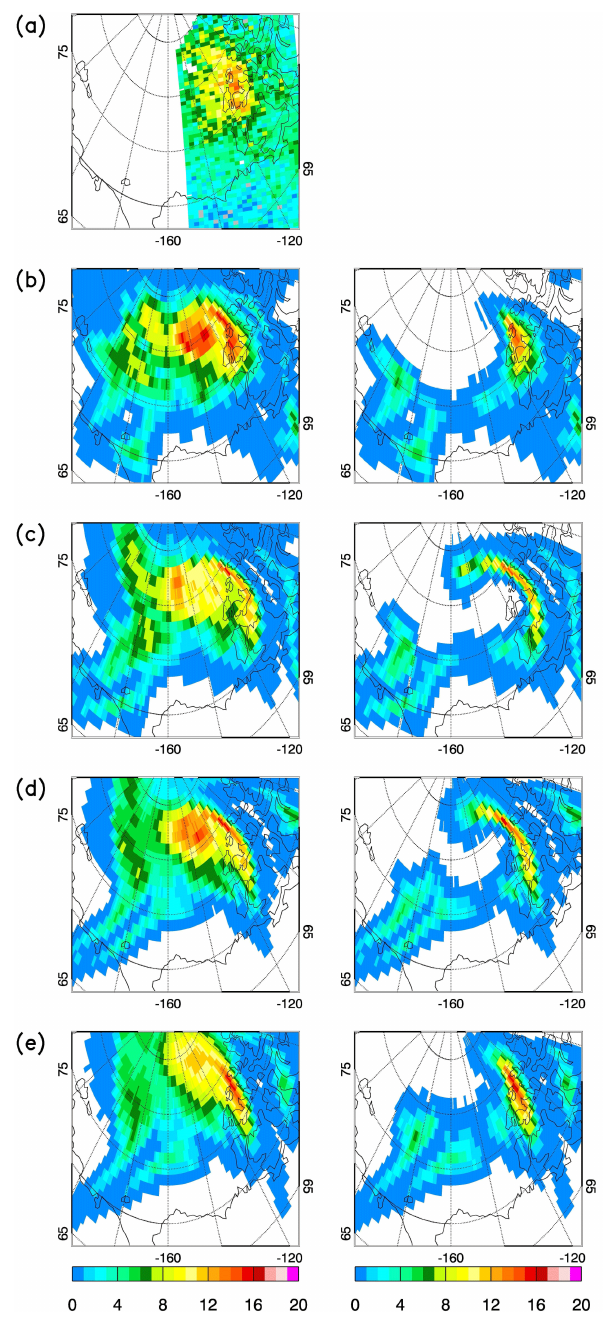
Figure 9. As in Fig. 8 but for FLEXPART (left) FS2 and (right) FS3 simulations for 2 April 2011 at 19:30UTC (dissolving stage of the